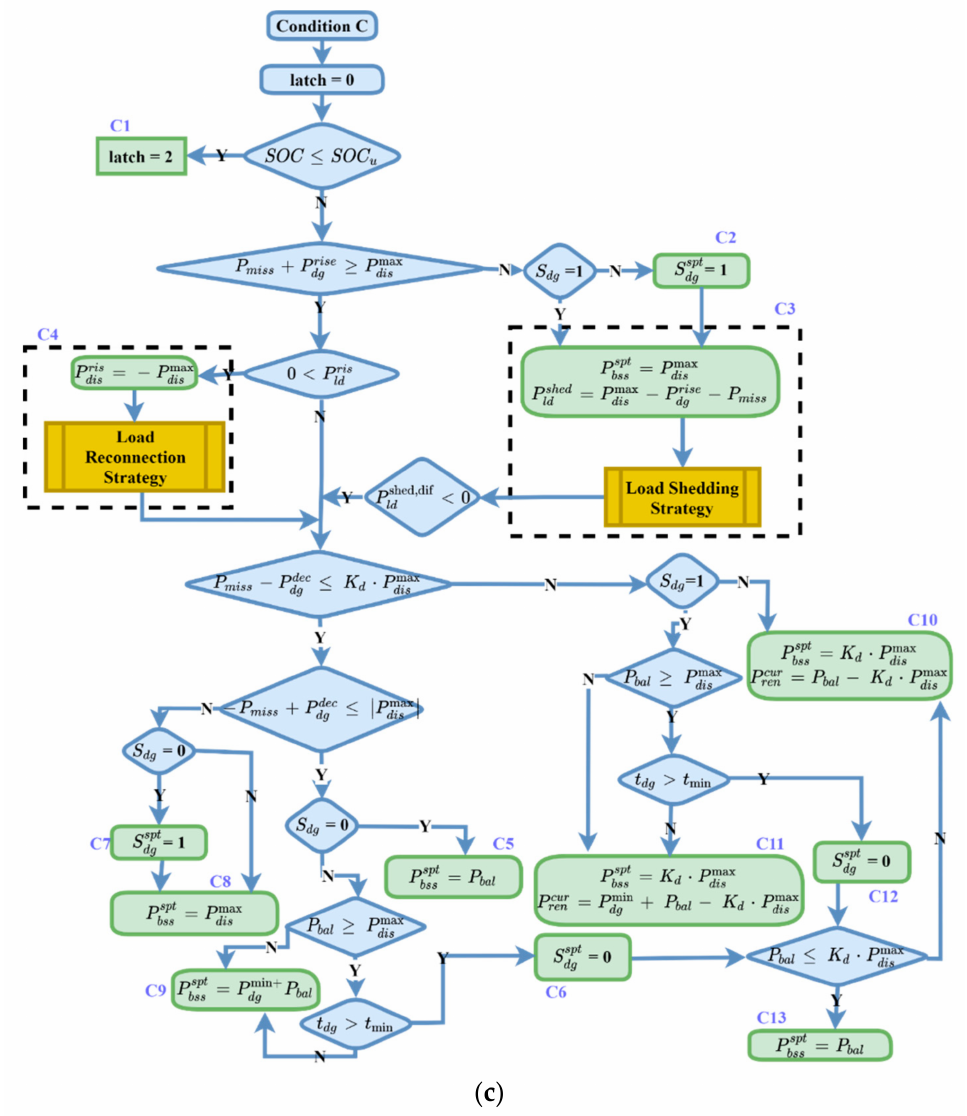
Figure 8. Control rules of dispatch function in SS2 based on the ranges of BSS’s SOC: ( a ) BSS force-charging control rule. ( b ) BSS power-smoothing control rule. ( c ) BSS force-discharge control